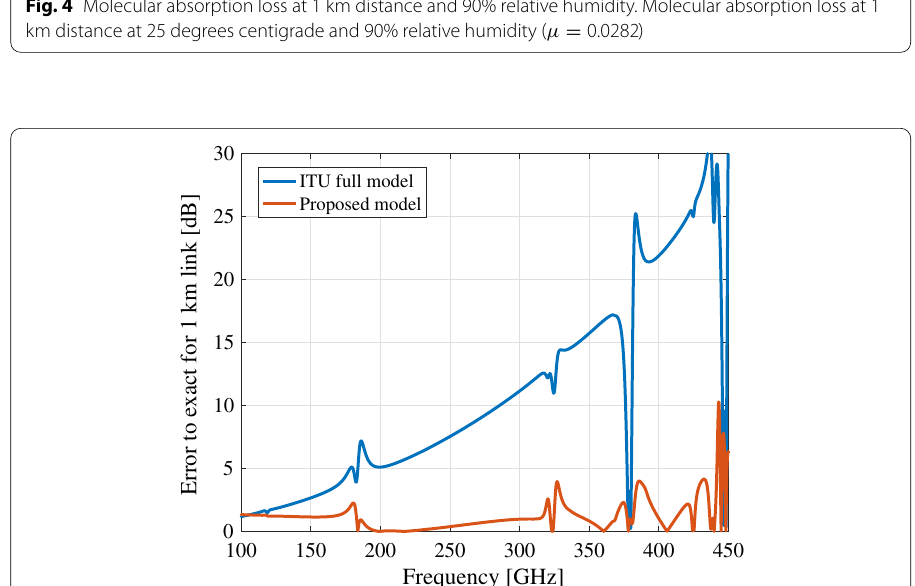
Fig. 5 Error of the model and comparison with ITU-R model. Absolute errors given by the ITU-R full